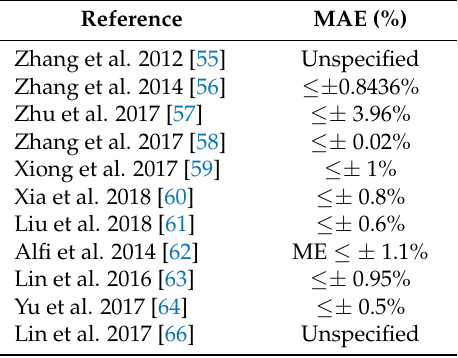
Table 5. MAE/ME of the H ∞ F and its variant-based method to estimate the SOC.